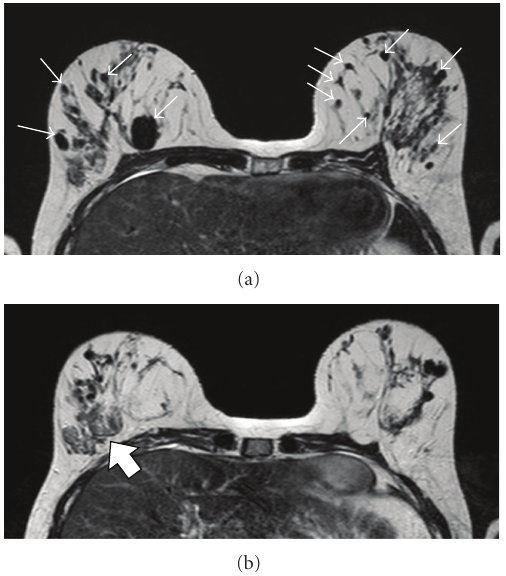
Figure 2: Transverse T2-weighted images show multiple coarse cal- cifications in both breasts ((a) small arrows) and a large, lobulated mass in the lower lateral quadrant of the right breast ((b) white arrow).